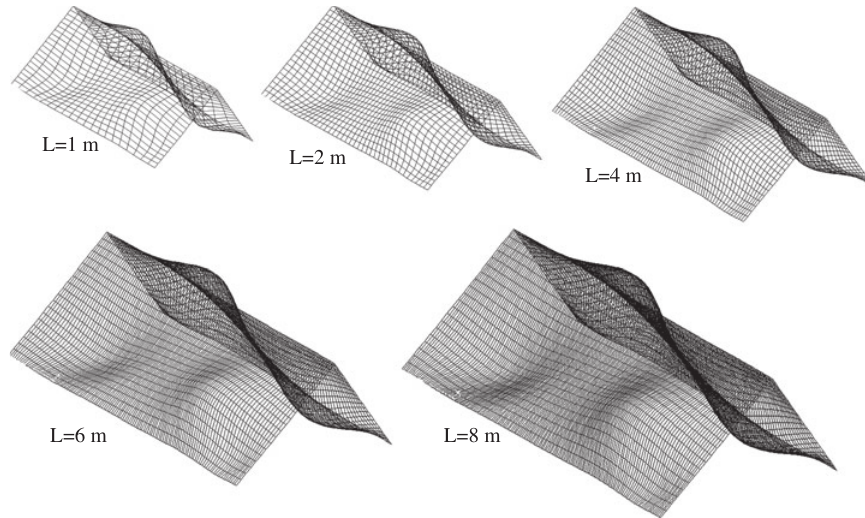
Figure 7 Thermal buckling modes for different plate lengths of one-fold laminated plates.